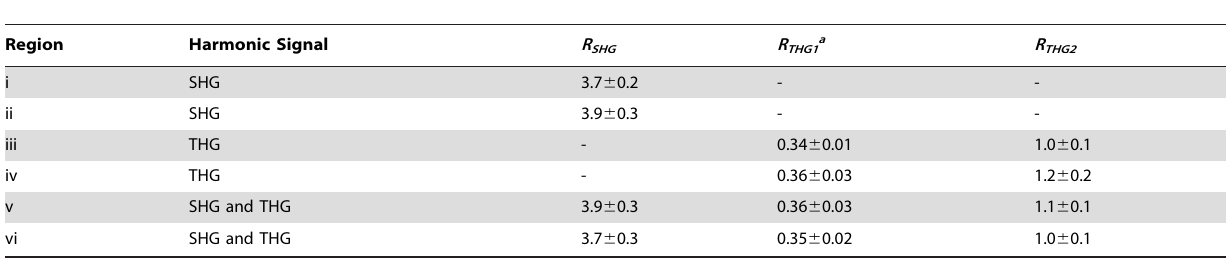
Table 1. PIPO SHG and PIPO THG fitting parameters of a red aplanospore of Haematococcus pluvialis .